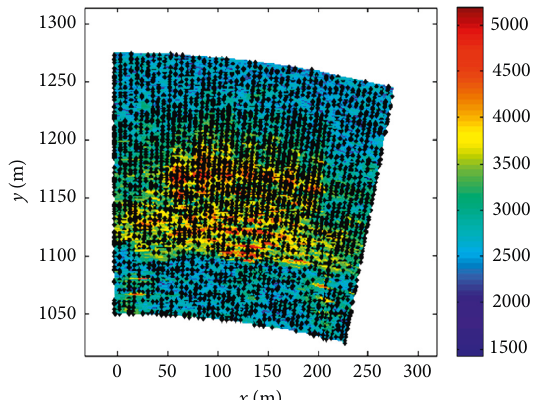
Figure 8: PS points selected using the T are PSs).